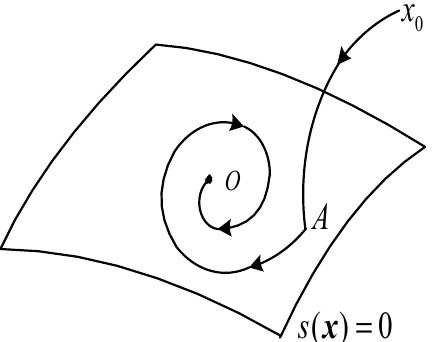
Figure 1. Schematic diagram of the principle, sliding mode control principle.